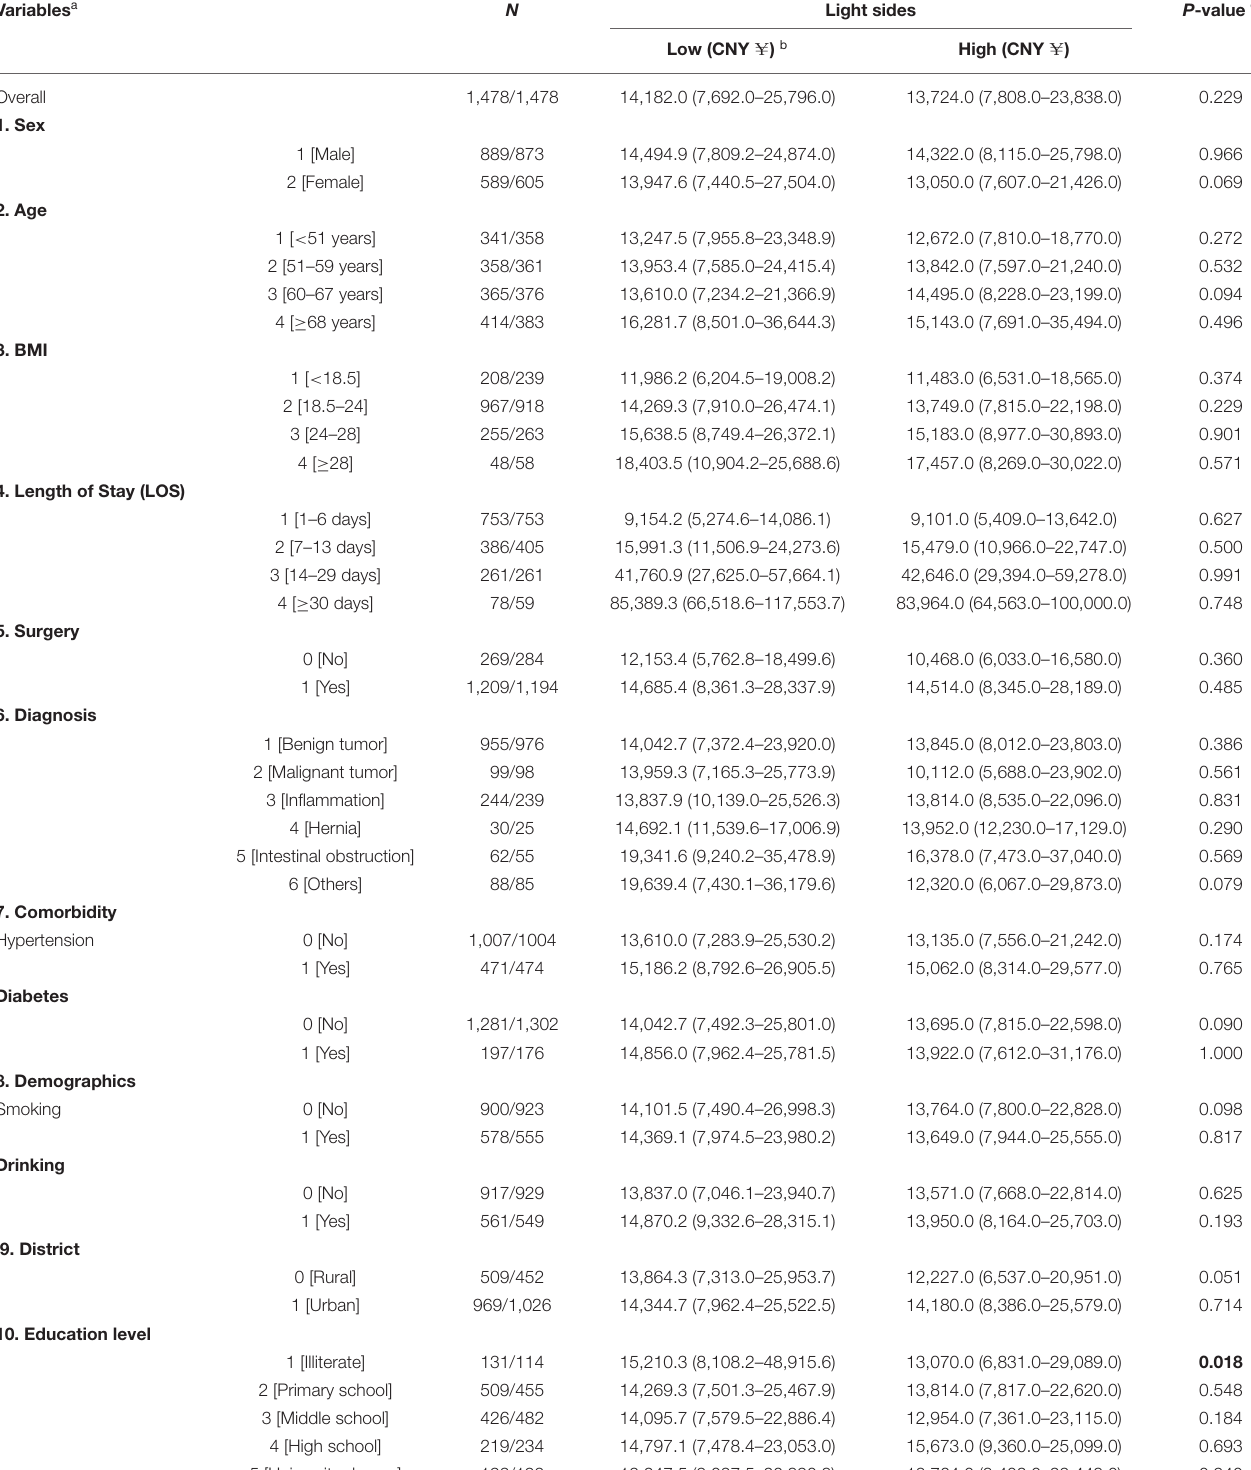
TABLE 2 | Total costs of patients by light sides of the hospital